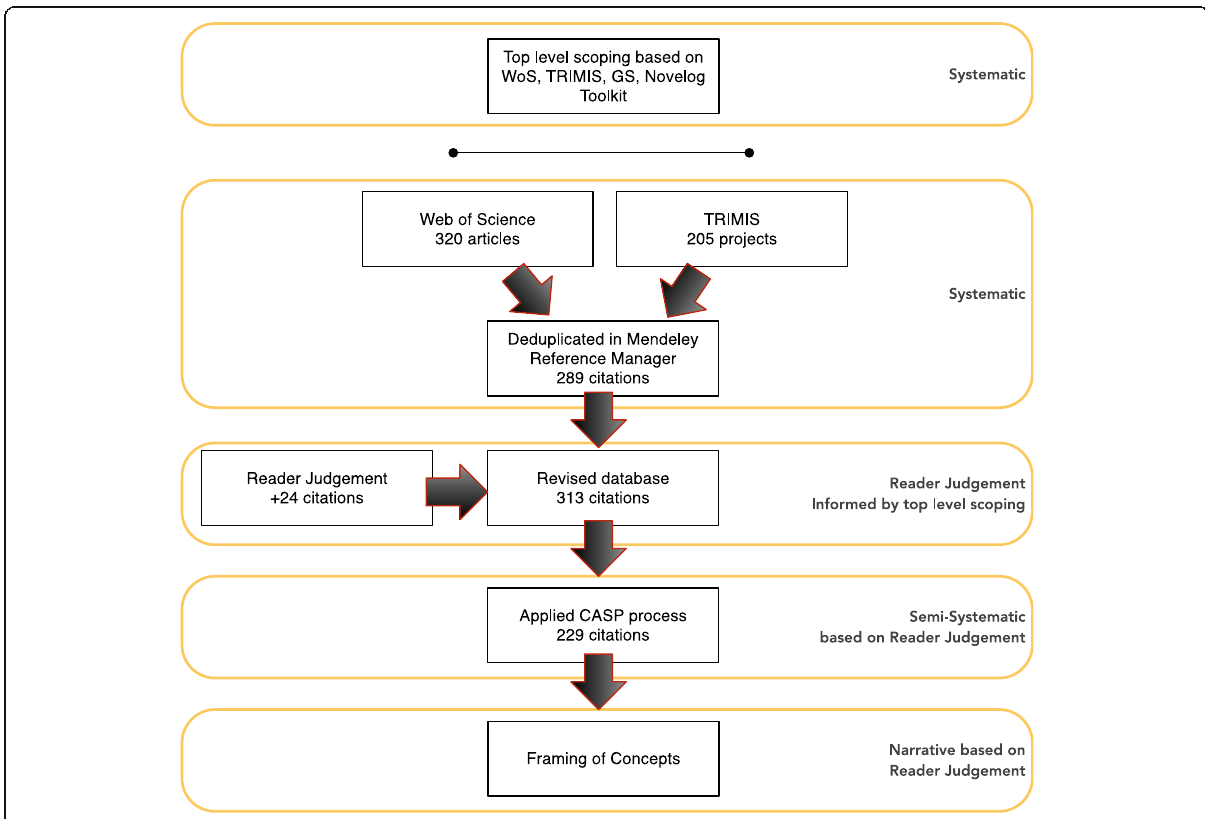
Fig. 1 Semi systematic review protocol as a